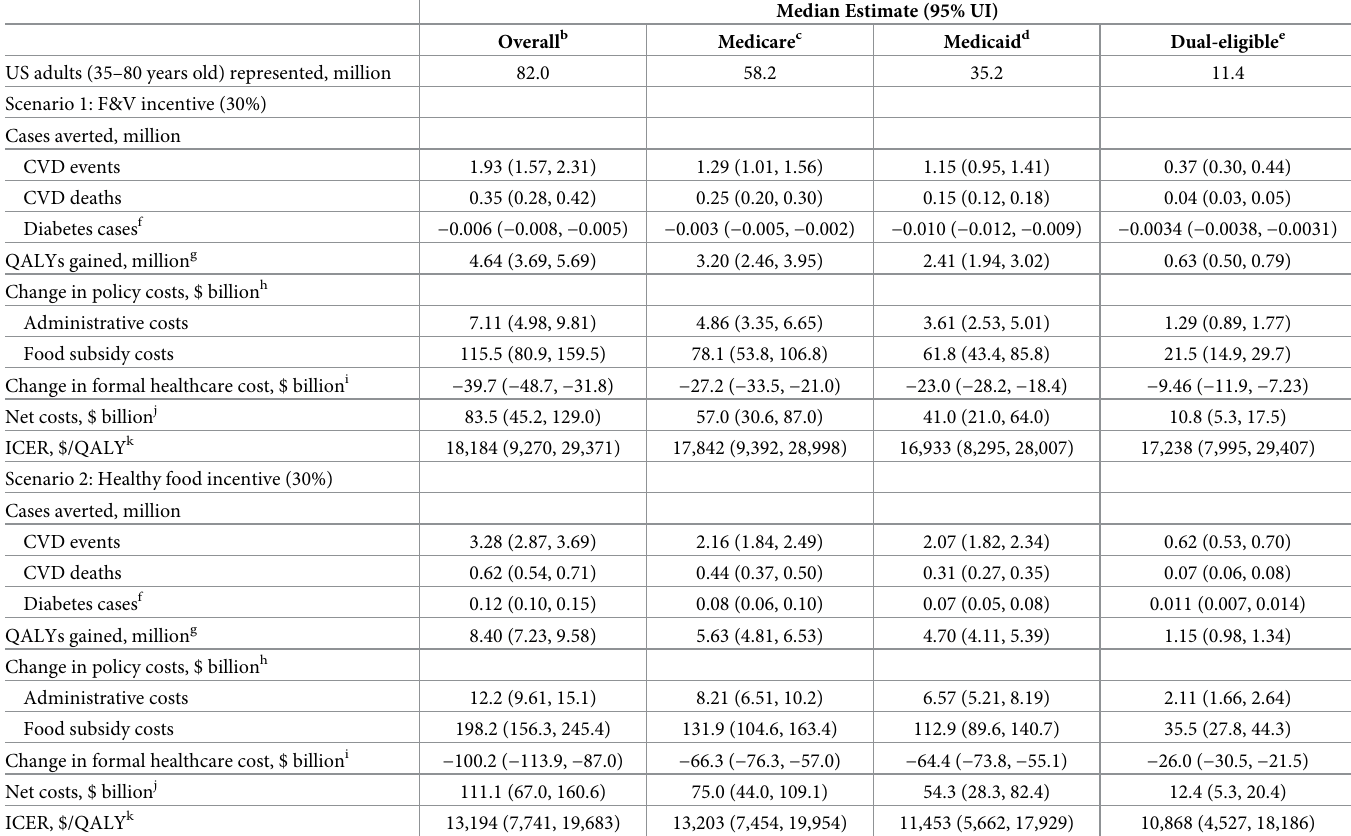
Table 2. Lifetime health gains, costs, and cost-effectiveness of 30% F&V incentive and healthy food incentive programs through Medicare and Medicaid from a healthcare perspective a